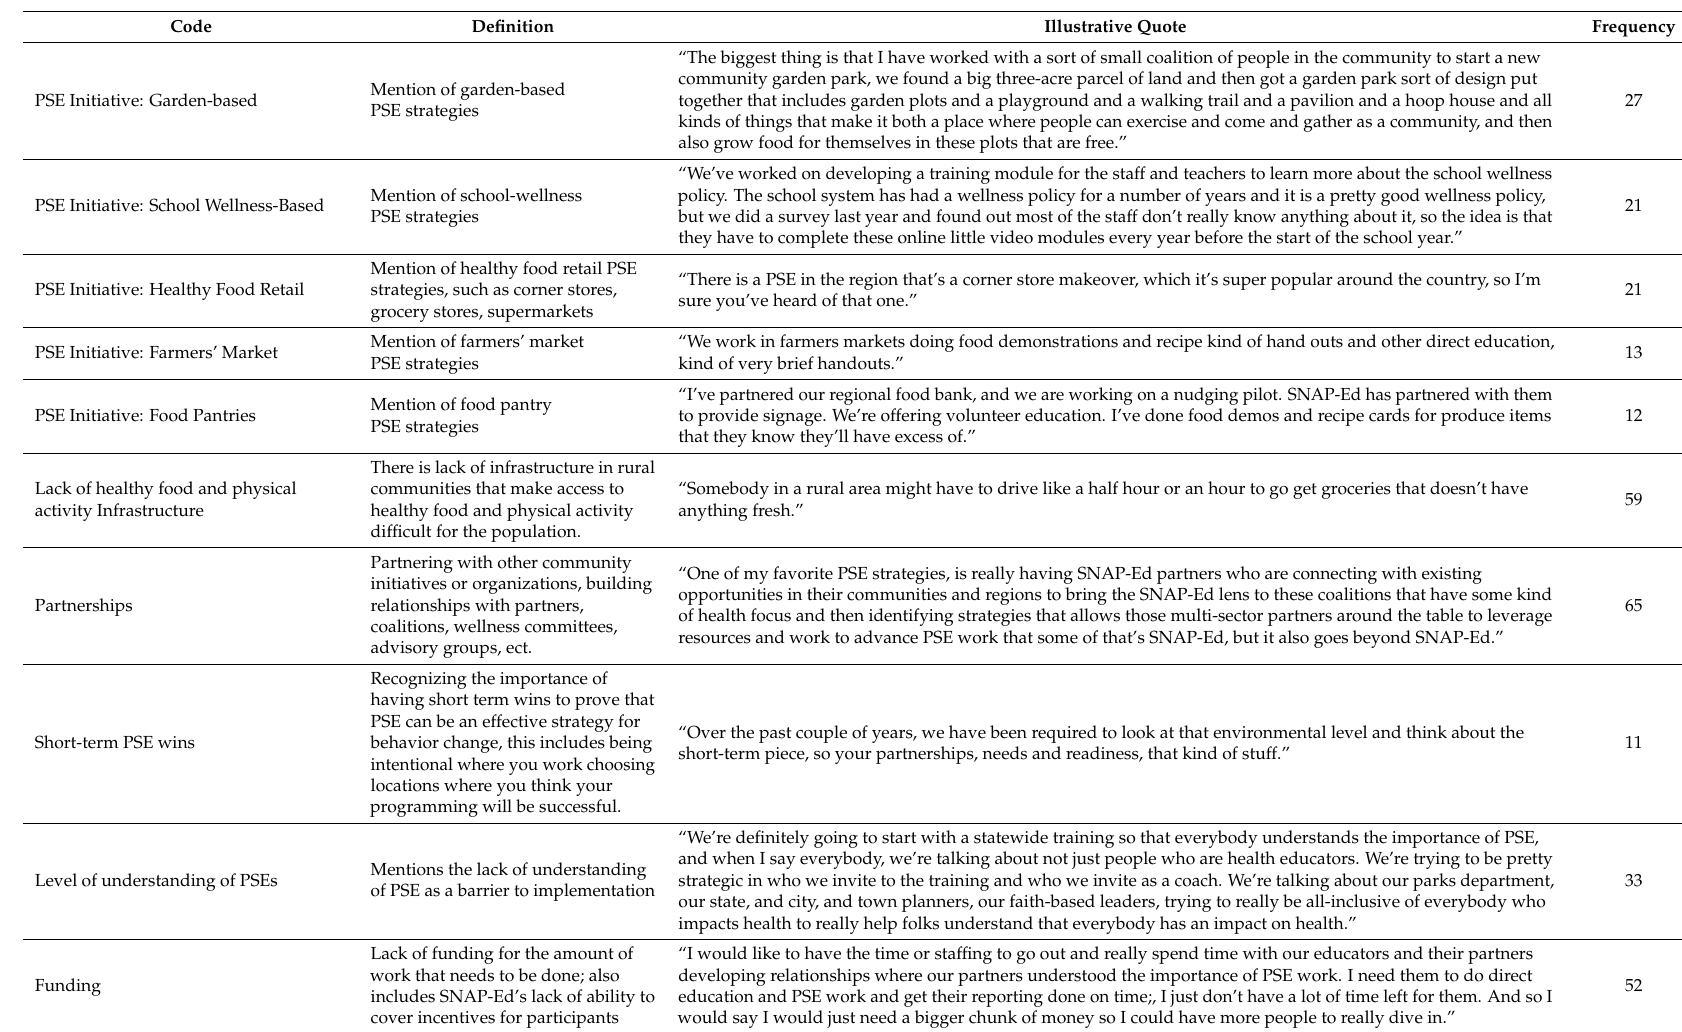
Table 3. Codebook for